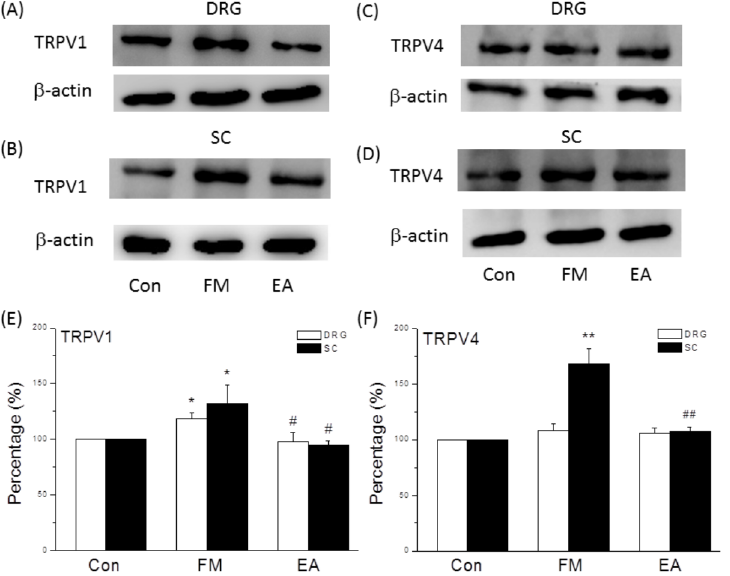
Fig 4. Upregulation of TRPV1 protein expression in DRG neurons from FM mice, upregulation of both TRPV1 and TRPV4 in lumbar spinal cord (SC) of FM mice, and reversal of overexpression by EA. (A) Western blots of DRG lysates showing TRPV1 upregulation in FM mice compared to control mice and reversal by EA. (B) Upregulation of TRPV1 protein in lysates from SC. (C) TRPV4 expression levels were unaltered in the DRG of Con, FM, and EA groups. (D) Upregulation of TRPV4 in the SC of FM mice and reversal by EA. β -actin was used as the internal control. (E, F) Proportions of immunopositive neurons. Con = Control; FM = acid induced fibromyalgia pain; EA = electroacupuncture. DRG = dorsal root ganglion. SC = spinal cord.